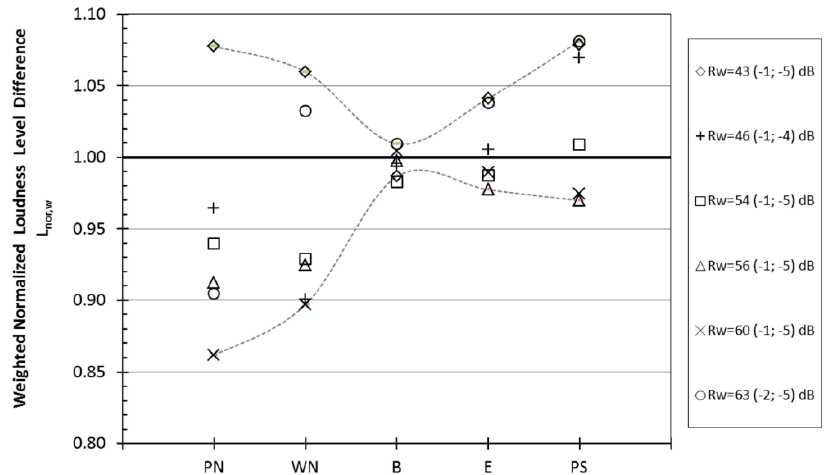
Figure 5. Weighted normalized loudness level difference ( L nor,w ) for different sound samples calculated for a single wall construction of sand ‐ lime brick of thickness ranging from 70 to 300 mm and calculated sound reduction index R w ( C ; Ctr ). The upper and lower dotted grey line indicates the region for the individual results. PN stands for pink noise, WN for white noise, B for Beethoven, E for Eminem, and PS for Party Sound.